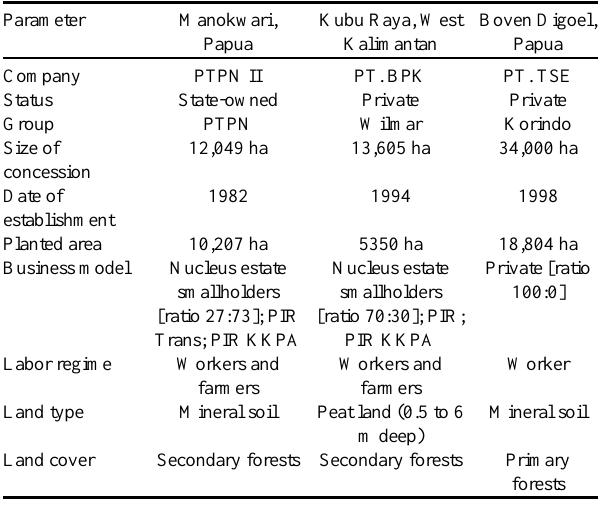
Table 5 . A summary of the research sites.